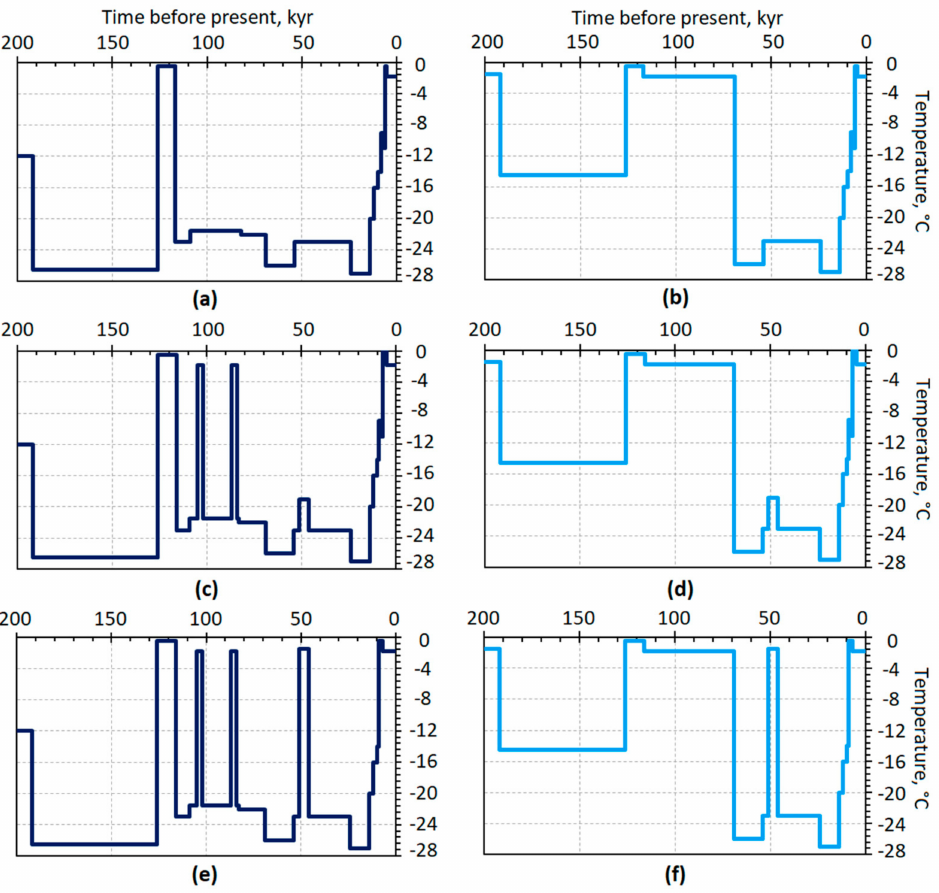
Figure 6. Paleotemperature scenario for isobath area: ( a , b ) 5 m; ( c , d ) 20 m; ( e , f ) 40 m. Dark blue line—for extraglacial conditions ( a , c , e ); blue line—for the glacial conditions ( b , d , f